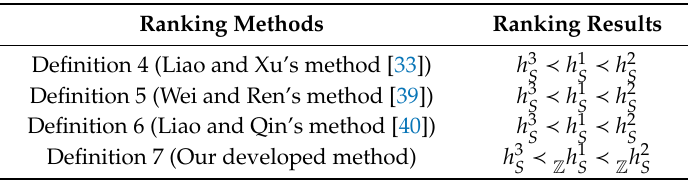
Table 2. Score measures of di ff erent hesitant fuzzy linguistic elements (HFLEs) and their corresponding ranking